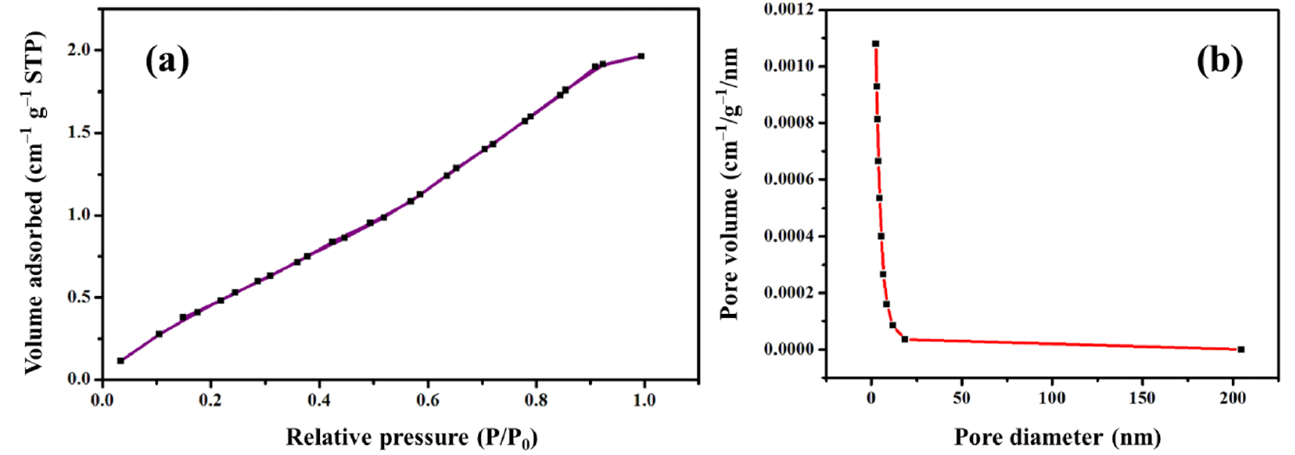
Figure 5. Surface area of pore size of green synthesized Ag NPs: ( a ) Nitrogen adsorption–desorption isotherm, and ( b ) Barret–Joyner–Halenda (BJH) pore size distribution plot.